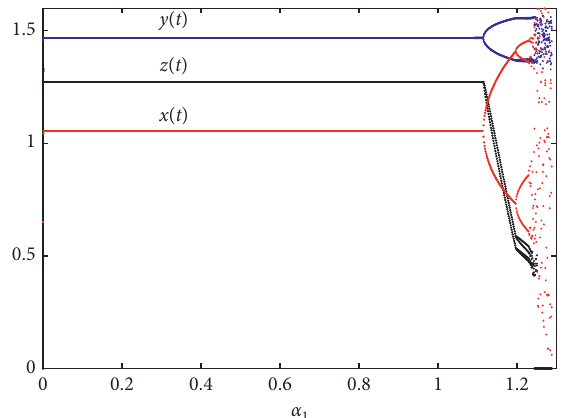
Figure 1: Bifurcation diagram for α